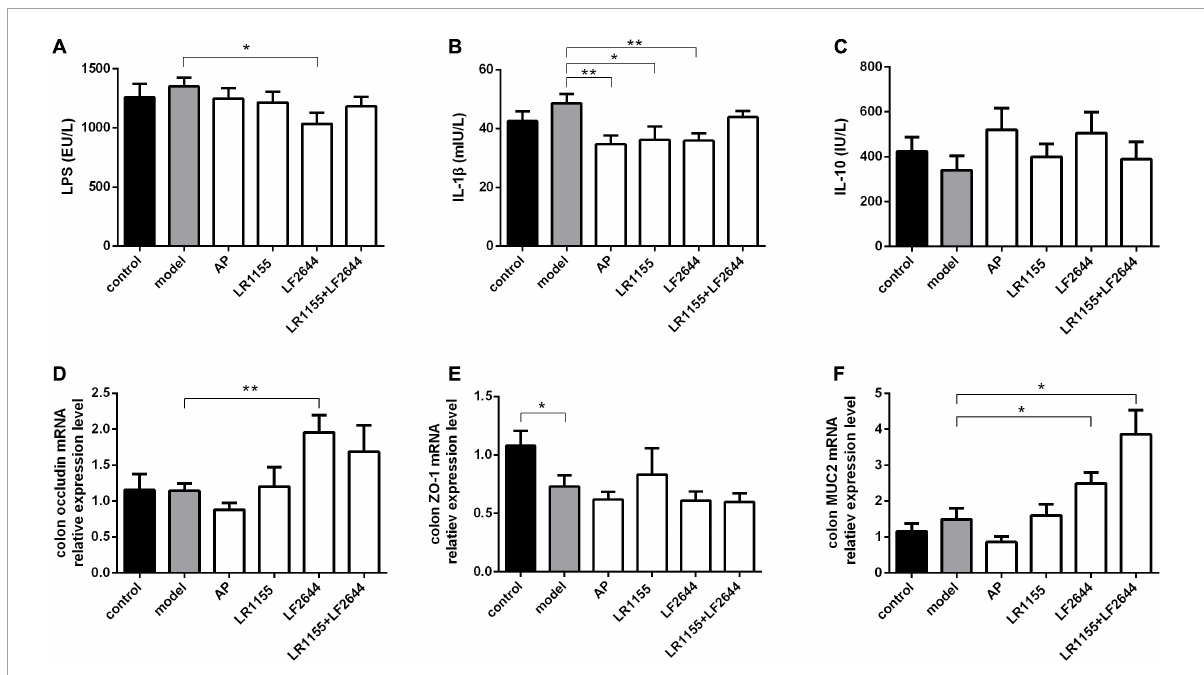
FIGURE4 Effects of LR1155 and LF2644 on inflammatory cytokines and intestinal barrier function in hyperuricemia rats. (A–C) Serum LPS, IL-1 β and IL-10 levels at the end of the experiment. (D–F) Gene expressions of occluding, ZO-1 and MUC2 in colon tissue. Data are expressed as mean ± SEM ( n = 10–12 per group). * P < 0.05, ** P < 0.01 vs. the model